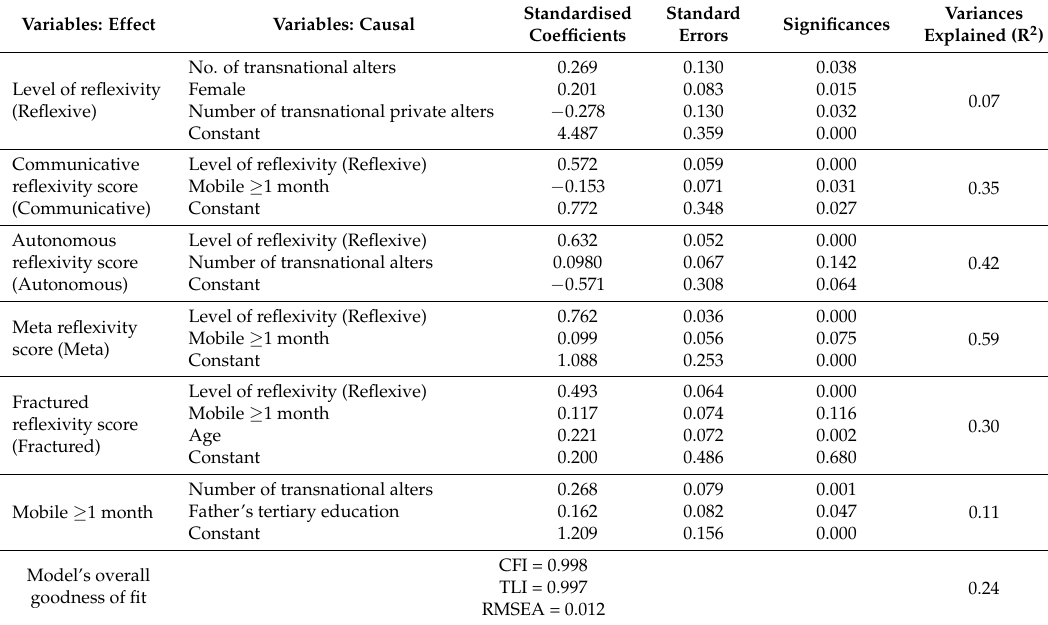
Table 4. Path analysis: variables, coefficients, and overall model fit.